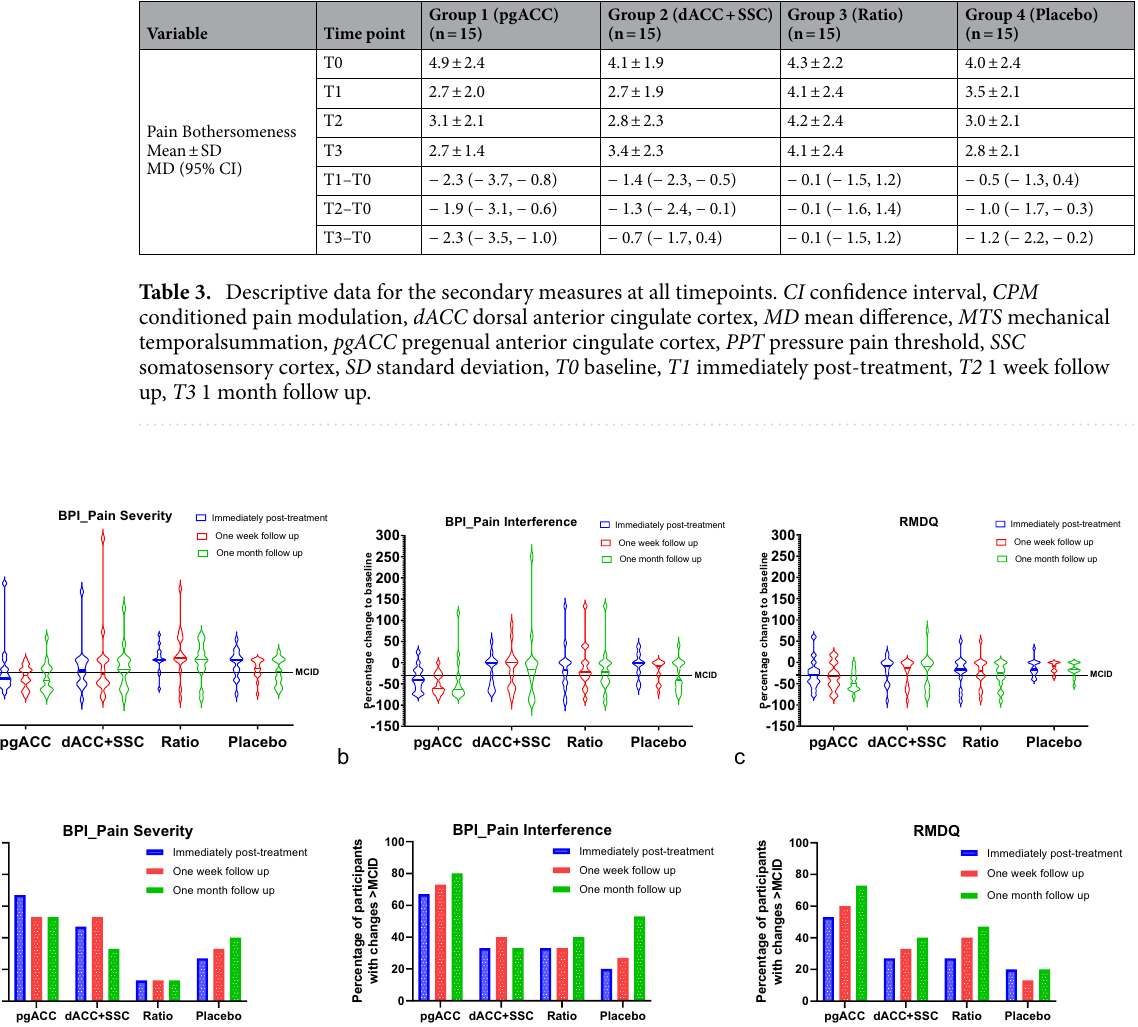
Further, to date, only one open-label study has explored the EEG-based NF training for treatment of CLBP 18 . To our knowledge, this pilot study is the first double-blinded randomised placebo-controlled feasibility trial to explore source-localised EEG ISG-NF training for treatment of CLBP. This study primarily explored feasibility,